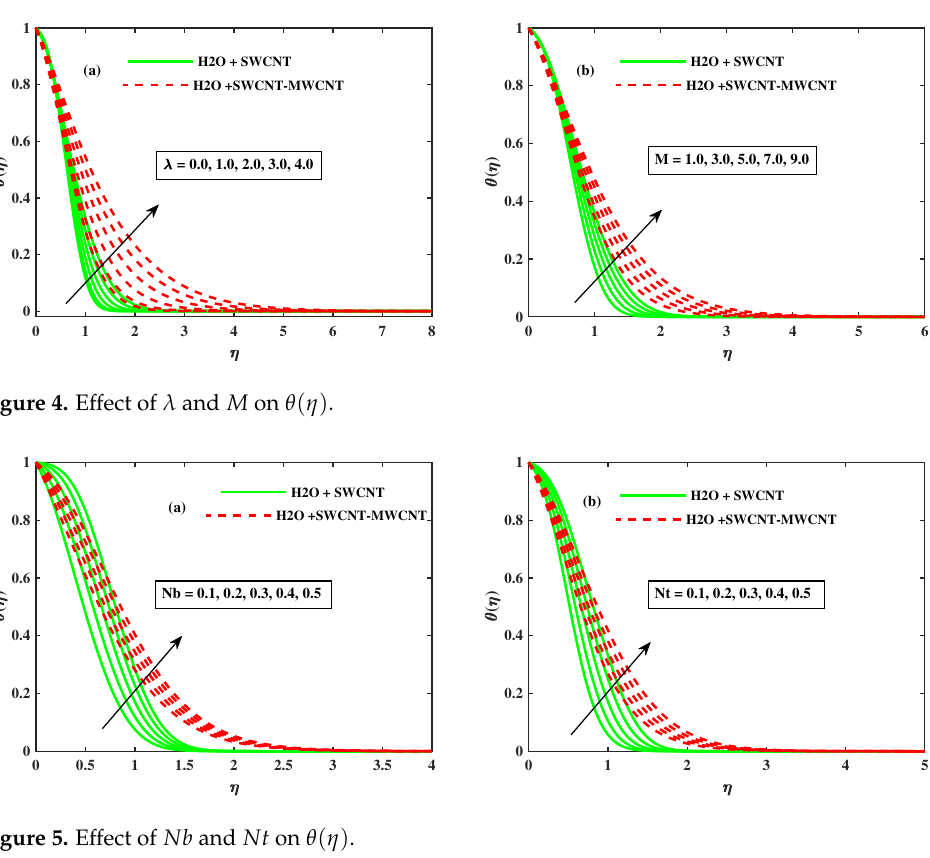
Figure 5. Effect of Nb and Nt on θ ( η )